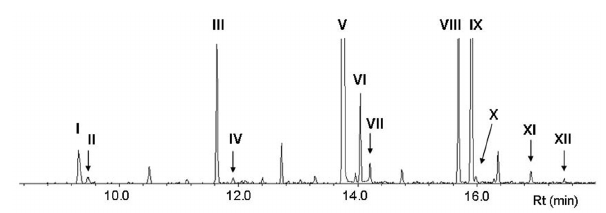
FIGURE 2 | GC–MS analysis (total ion chromatogram,TIC) of fatty acid methyl esters derived from the lipids in pheromone glands of